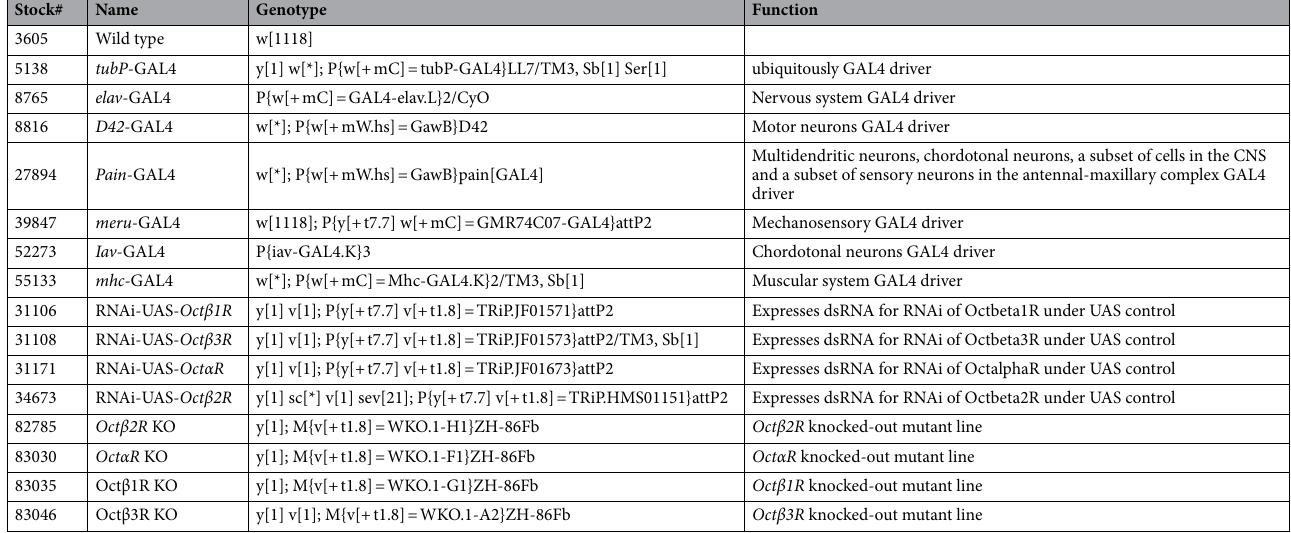
Table 1. Stock number, name, genotype and usage of Drosophila lines used in this